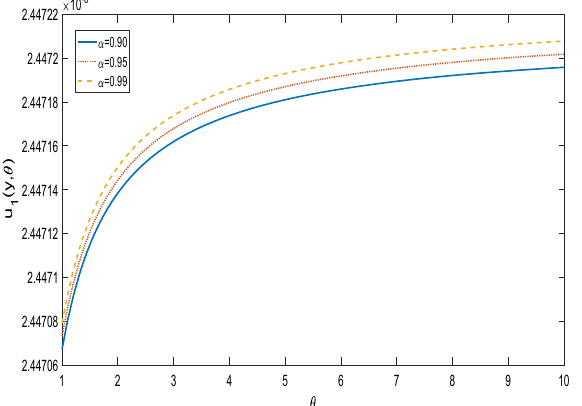
Fig. 5 Graphical representation of the dimensionless piezometric head w.r.t. dimensionless time at distance y = 5.5. for fixed β = 0 . 90 , ζ = 10 , η = 2 and α = 0 . 90 , 0 . 95 0 . 99